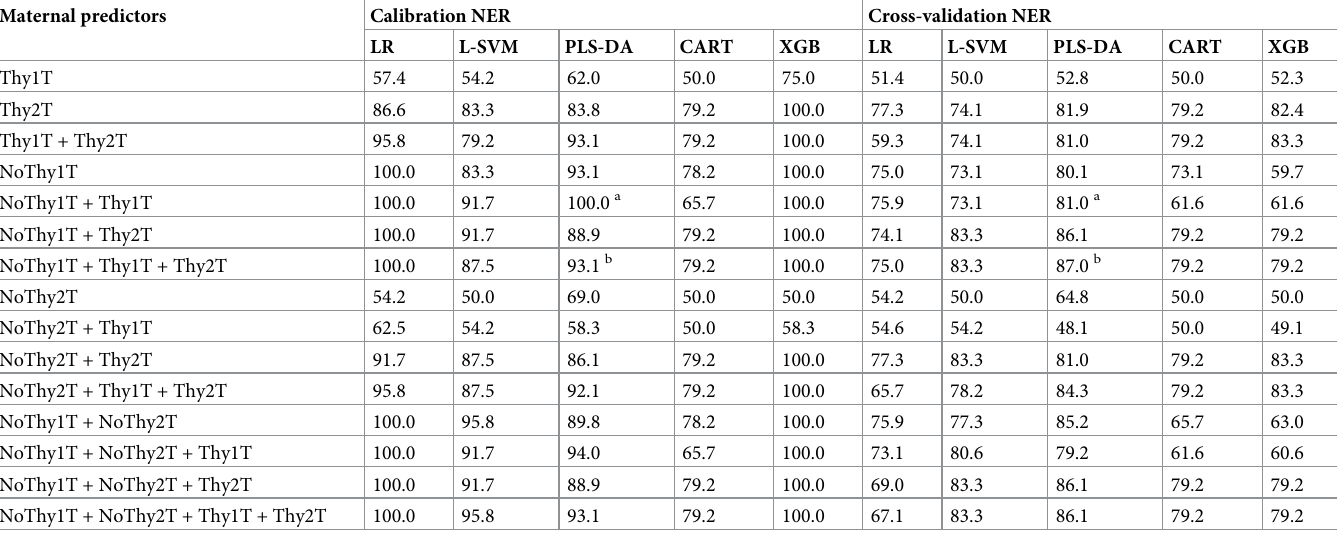
Table 2. Non-error rate of machine learning models that predict gestational diabetes mellitus based on different maternal variables.